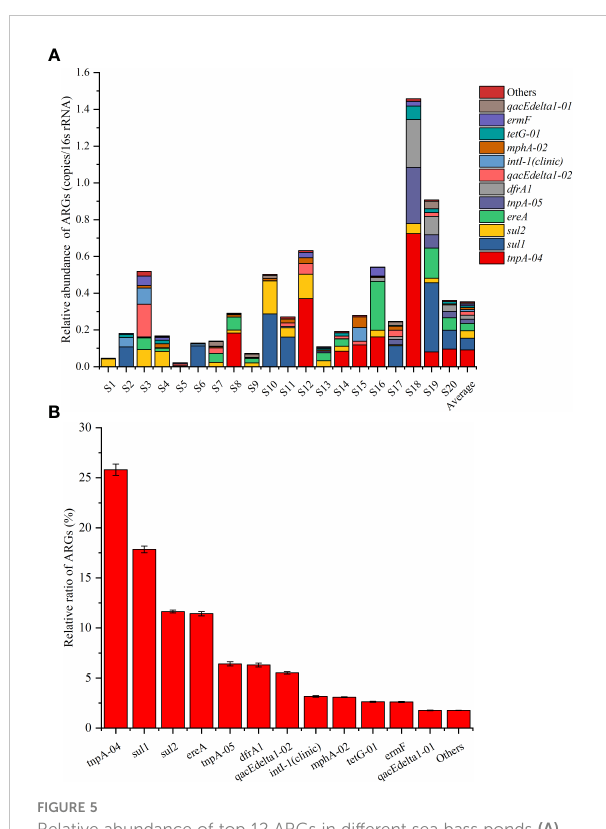
FIGURE 5 Relative abundance of top 12 ARGs in different sea bass ponds (A) and the relative ratio of the top 12 ARGs over the 20 ponds (S1 – S20). Values show means and 1 standard error of mean (mean ± SEM, n = 20) (B) .